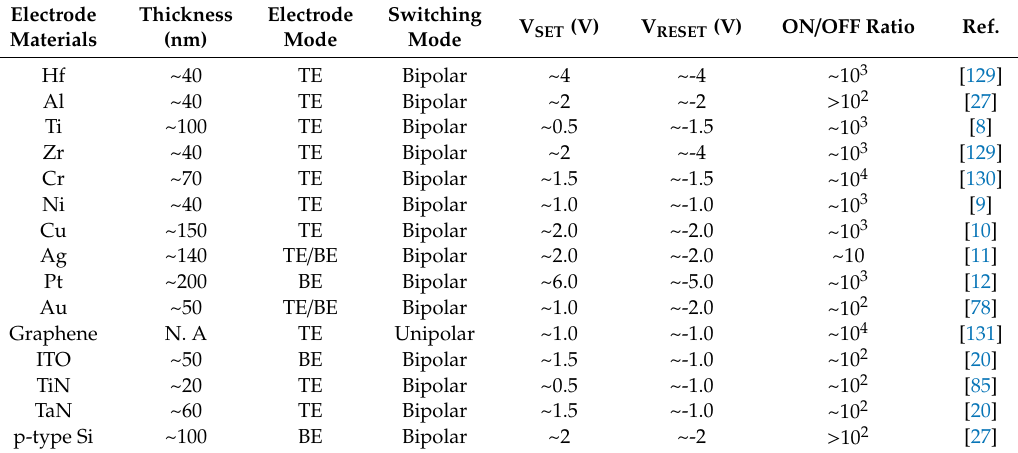
Table 2. RRAM devices with various materials as electrodes.